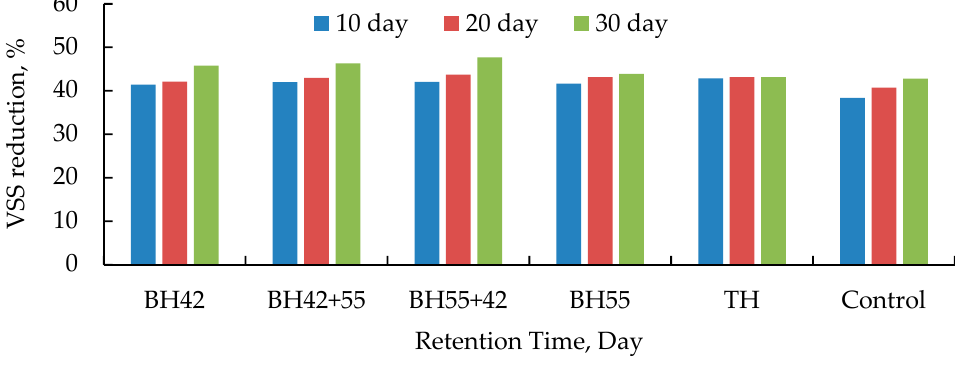
Figure 6. Reduction in VSS concentration after the biological methane potential (BMP)